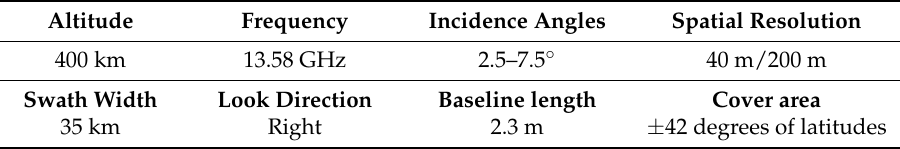
Table 1. Parameters of Tian Gong 2 Interferometric Imaging Radar